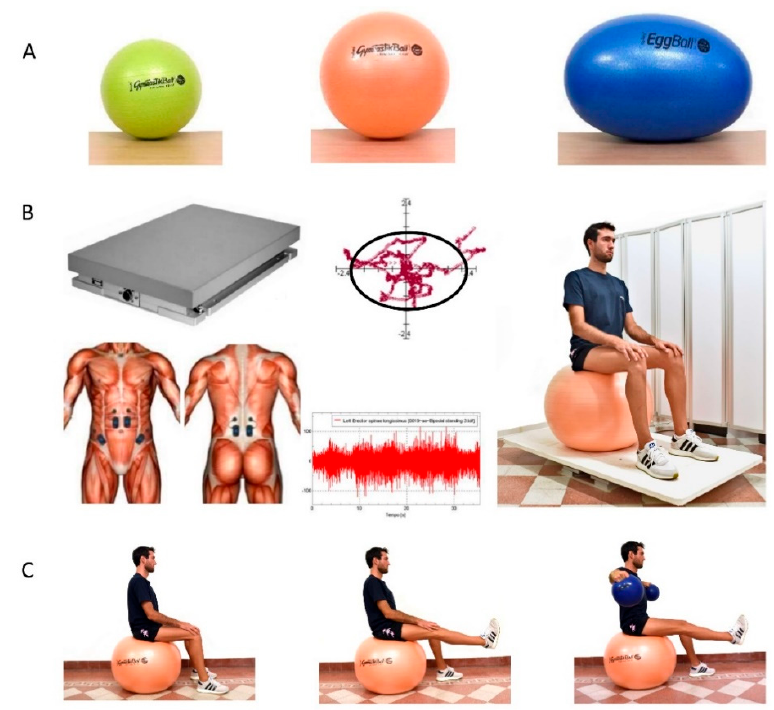
Figure 1. Experimental design of the cross-sectional study. ( A ) Gymnastic balls employed in the experimental trials; ( B ) details of the force platform and sensor location on the left, and experimental setup on the right; ( C ) visual representation of the tasks performed by the subjects. From left to right: bipedal seated (BS), unipedal seated (US), and dynamic exercise (EX). In the BS condition, the barefooted subjects were instructed to sit on the gymnastic ball with hands naturally resting on their knees and the trunk in an upright position. Both feet were placed on the force platform. In the US condition, the barefooted subjects were instructed to sit on the gymnastic ball with hands naturally resting on their knees and the trunk in an upright position. The nondominant lower limb was raised parallel to the ground with the knee fully extended. In the EX condition, the barefooted subjects, starting from a seated position, were asked to perform alternate leg extensions and sidearm lateral raises while gripping two 1-kg kettlebells. The velocity of both leg extensions and arm lateral raises was standardized by setting a metronome at 50 beats per minute. The support surface on the force platform was enlarged by screwing a wooden board (length 1.50 m; width 0.80 m; depth 0.03 m) on it, allowing both the feet and the gymnastic ball allocation. The distance between the feet and the gymnastic balls’ posterior margin was standardized to the length of the right lower limb of the subjects, measured from the anterior superior iliac spine to the ankle’s medial malleolus. Subjects were instructed to gaze at a thin line vertically placed on a white wall in front of them, at 0.8 m. For each experimental condition, three trials lasting 30 s were performed with opened